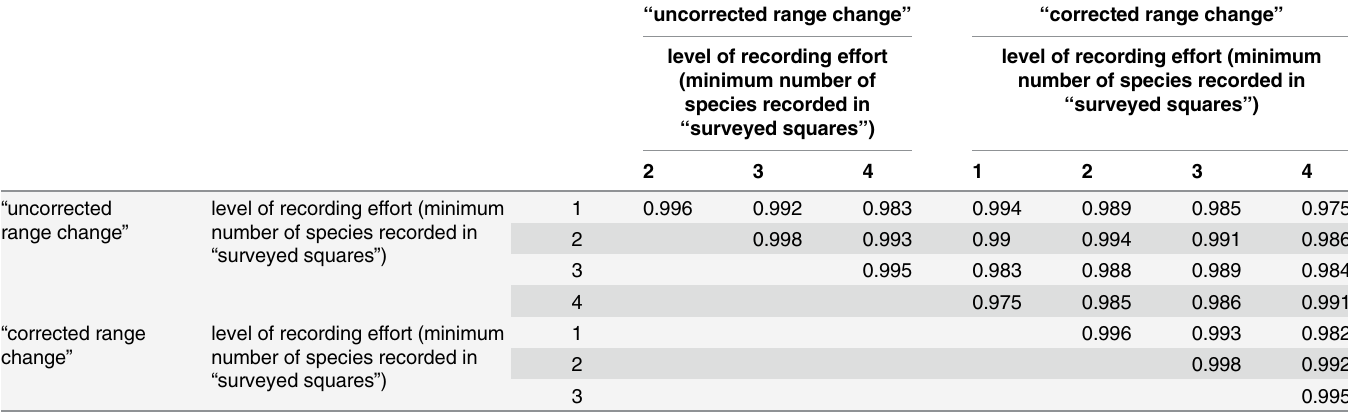
Table 3. Correlation between range change values.